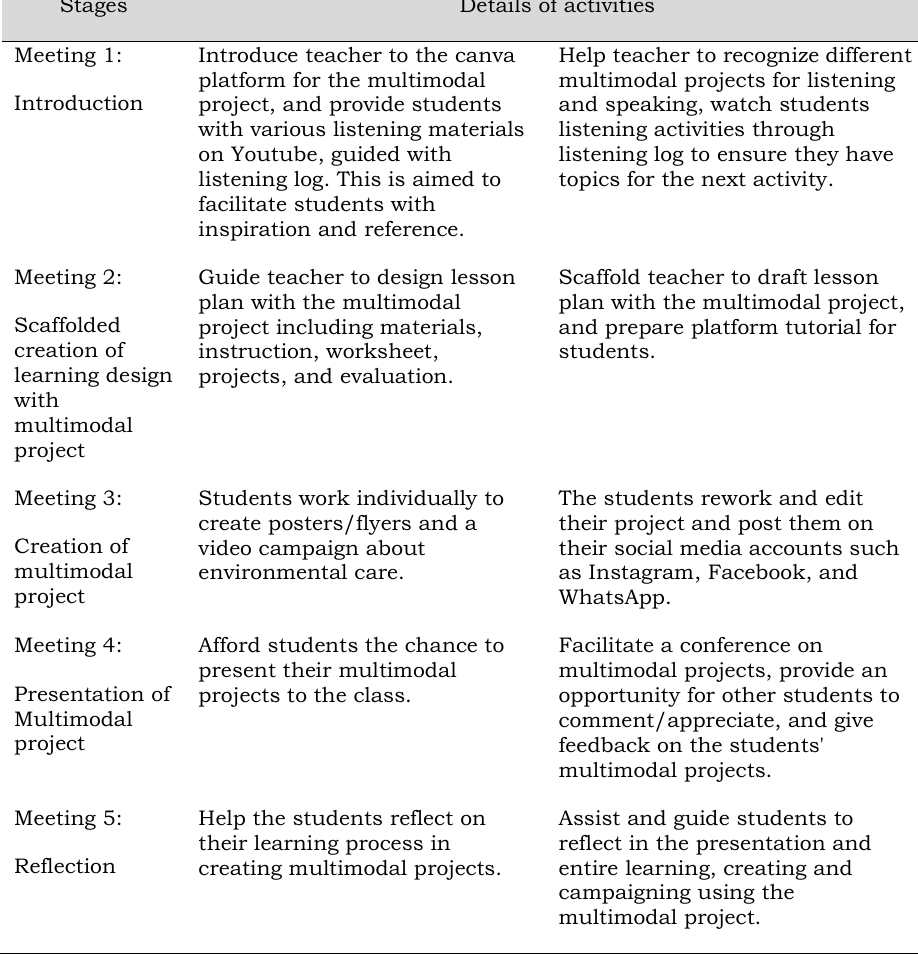
Table 2. The learning stage of Multimodal Project-based learning